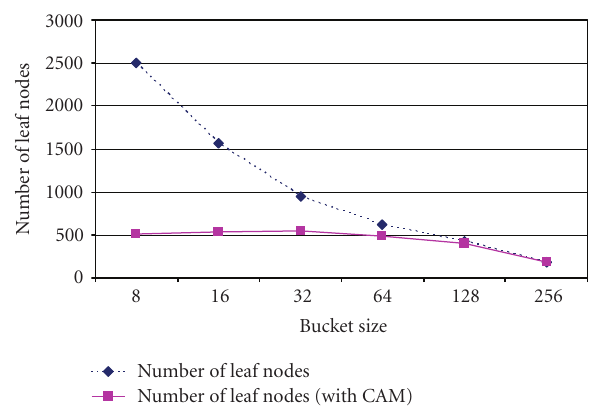
Figure 9: The e ff ect on the number of leaf nodes of restricting the maximum depth of the tree (number of levels) to 5 using CAM.